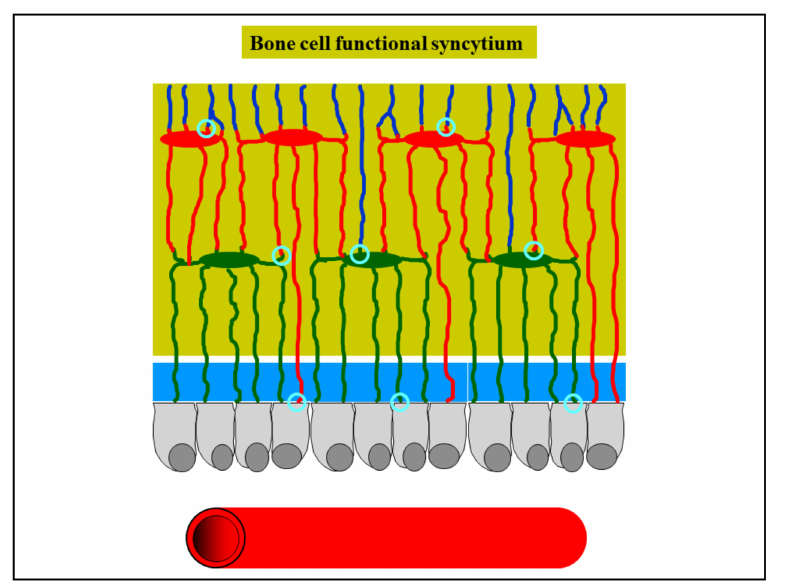
Figure 10. Schematic drawing showing osteocytes remaining in contact with each other by gap junctions (light blue circles), forming a functional syncytium which also stays in contact with the osteoblasts covering the bone growth surfaces (see text for further explanation).